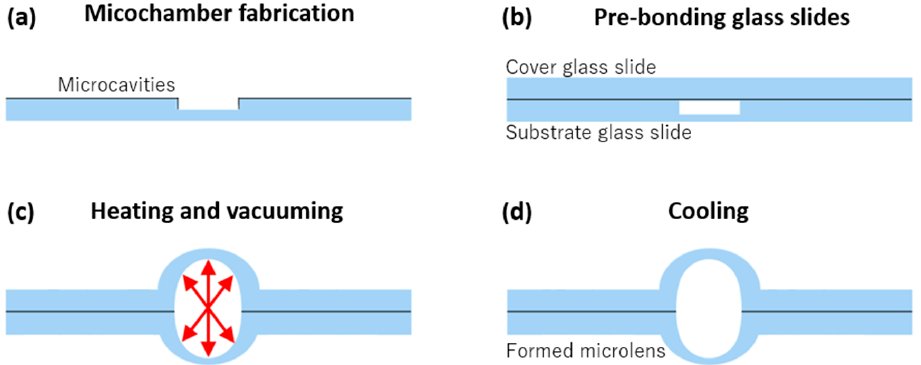
Figure 2. Main steps for the thin glass microlens fabrication. ( a ) Microcavities were prepared on one glass slide as the substrate. ( b ) Two glass slides were pre-bonded together by gently pressing. ( c )